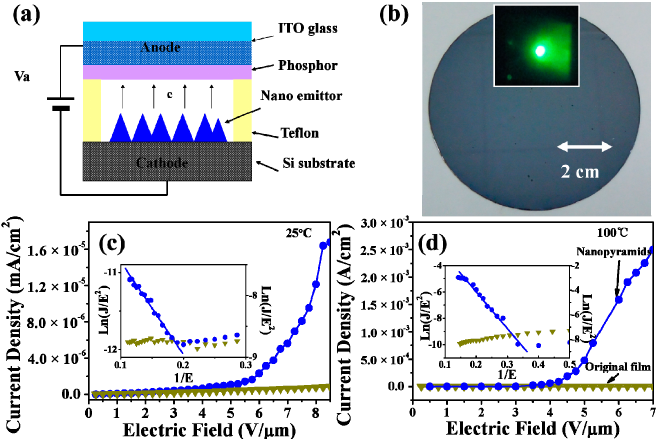
Figure 8. ( a ) Schematic of the field emission measurement for VO 2 nanopyramid thin films. ( b ) Photograph of a VO 2 nanopyramid thin film deposited on 3-inch silicon substrate. The inset shows a photograph of the green phosphor at an 8 V/ μ m electrical field. ( c , d ) J ‒ E curves for the original (inverted triangle dotted dark yellow lines) and the oxygen etching treated (circle dotted blue lines) VO 2 films. The results were measured at 25 ( c ) and 100 °C ( d ), respectively. The inset in ( c ) and ( d ) shows the Fowler ‒ Nordheim plots for the corresponding VO 2 films.